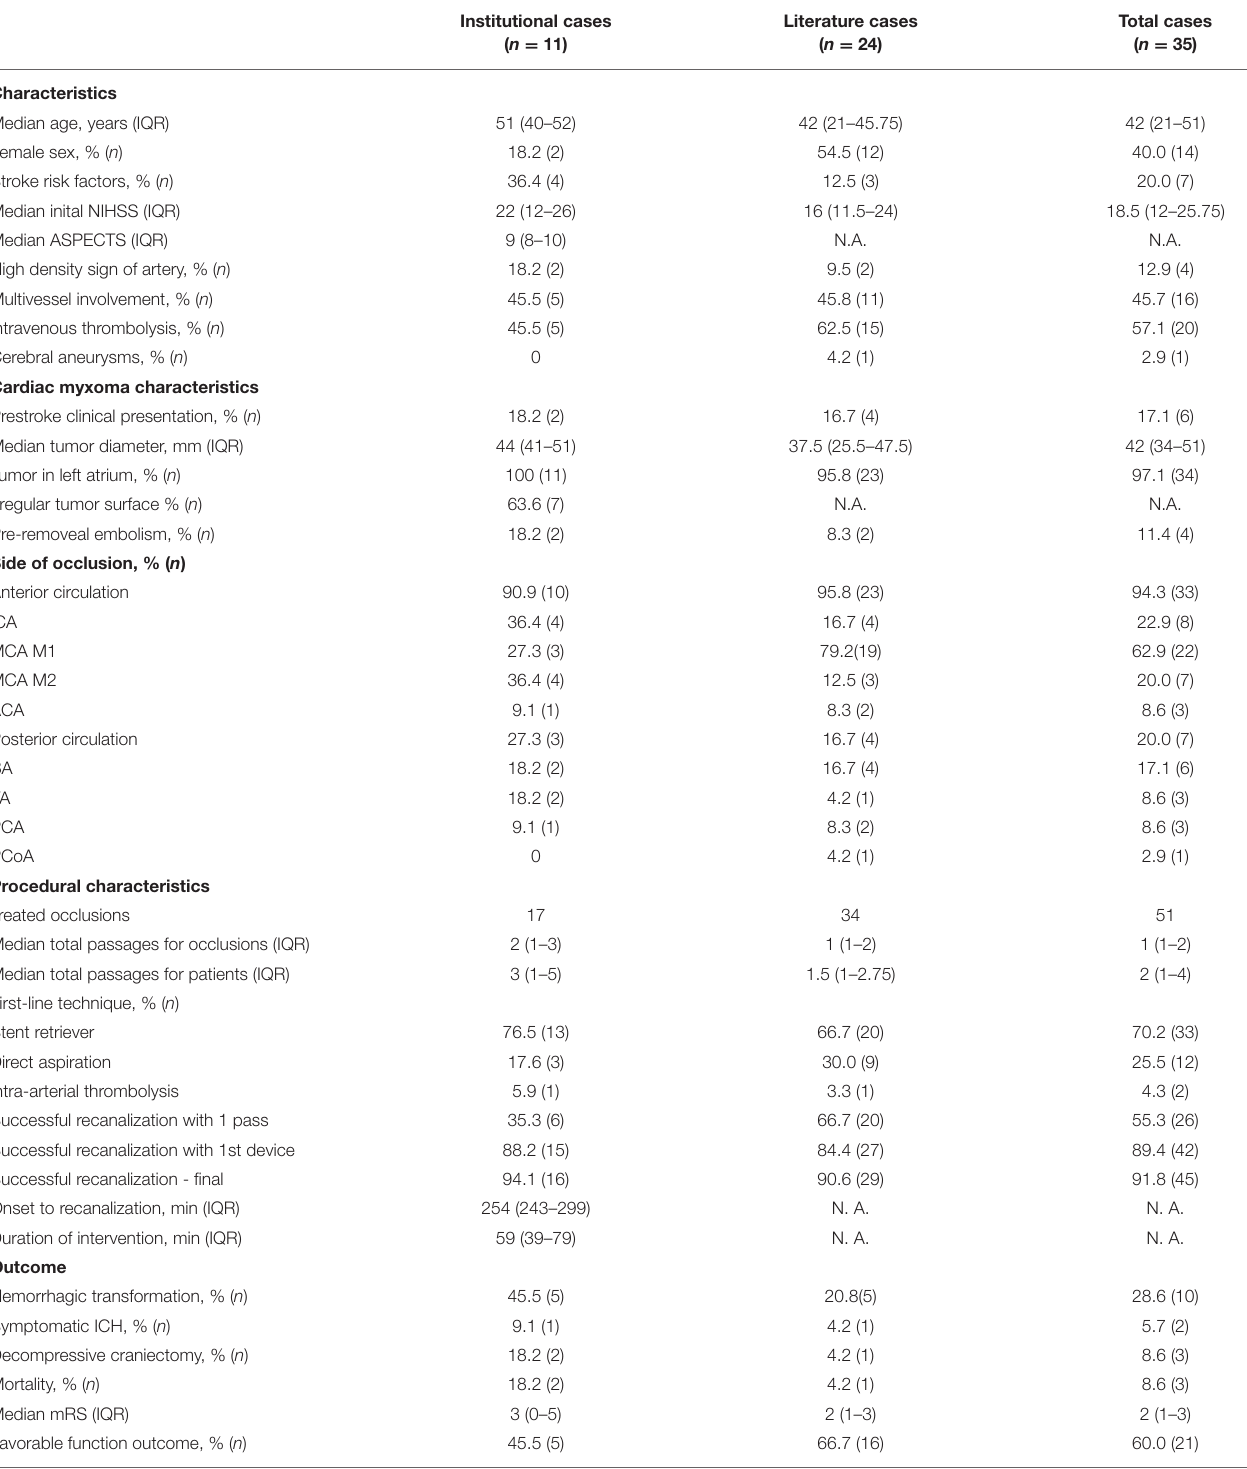
TABLE 2 | Clinical characteristics, periprocedural and outcome results of CM-AIS